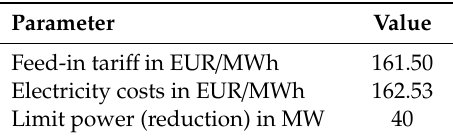
Table 2. Economic data for the adopted